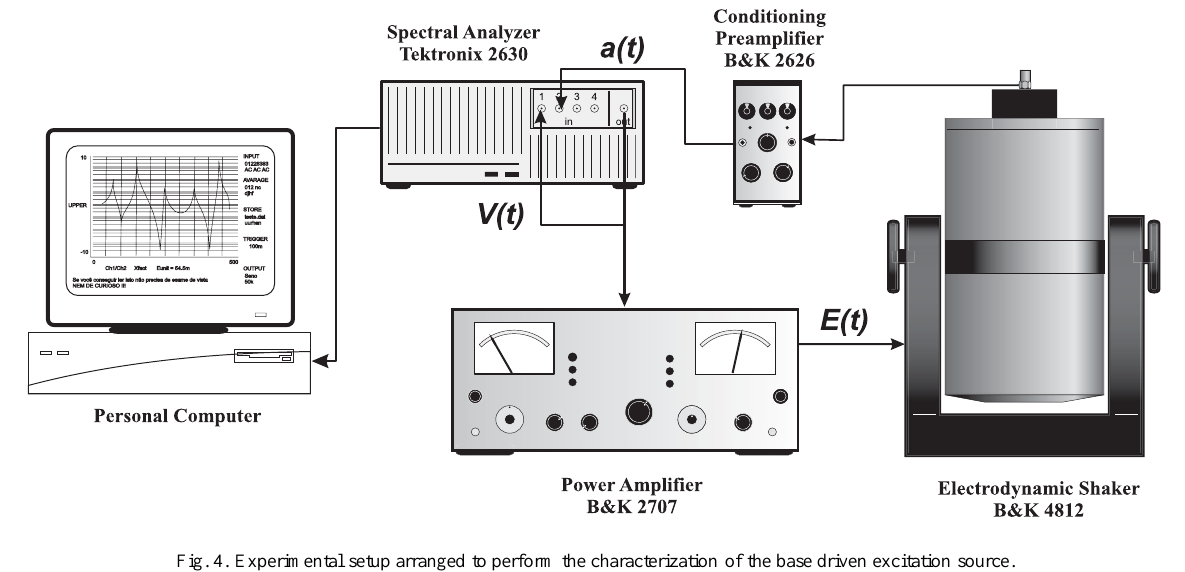
Fig. 4. Experimental setup arranged to perform the characterization of the base driven excitation